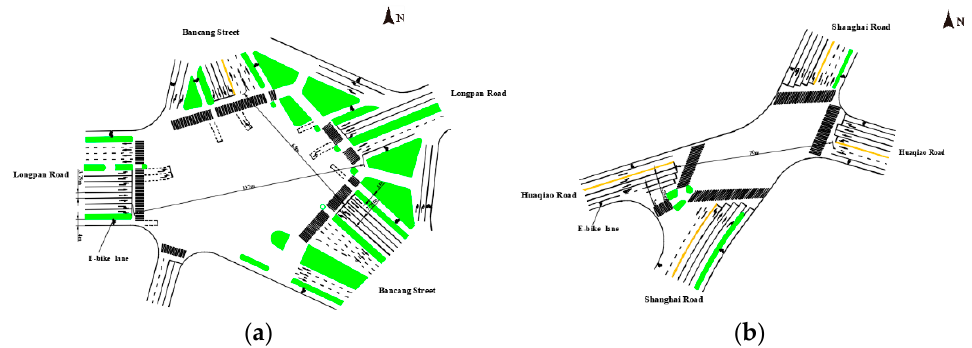
Figure 1. A diagram of the intersection: ( a ) the intersection at Longpan Road and Bancang Street; ( b ) the intersection at Shanghai Road and Huaqiao Road. Table 2. Survey site-related characteristic parameters.